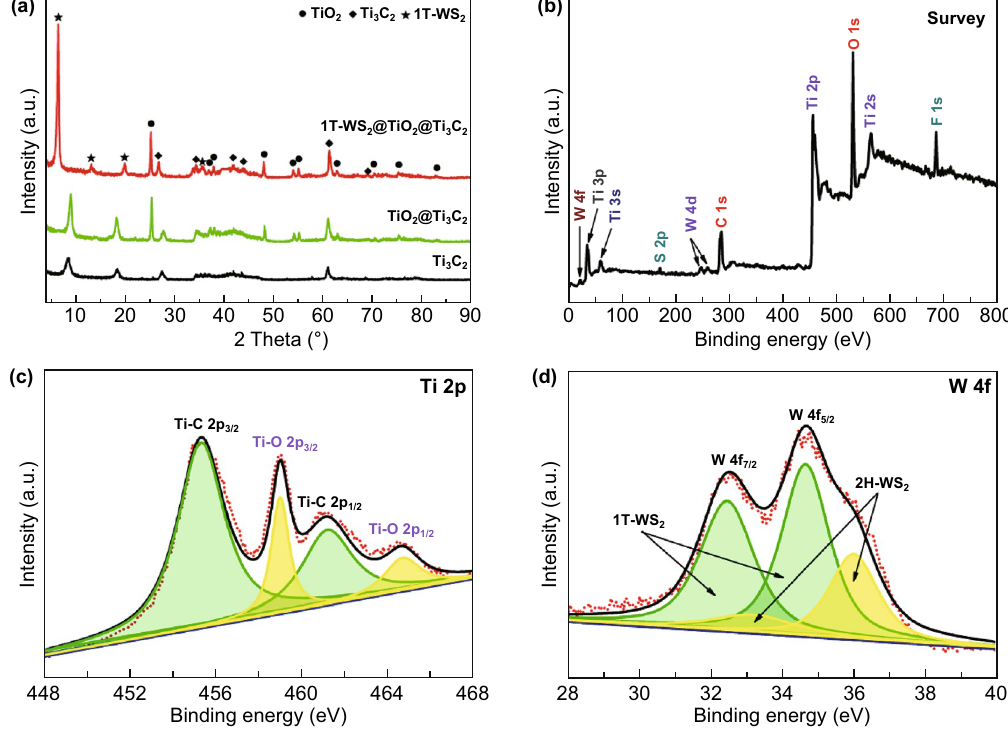
Fig. 1 a XRD patterns of Ti 3 C 2 , TiO 2 @Ti 3 C 2 , and 1T-WS 2 @TiO 2 @Ti 3 C 2 composites (15 wt% WS 2 ); b fully scanned XPS spectrum, c Ti 2 p , and d W 4 f XPS spectra in